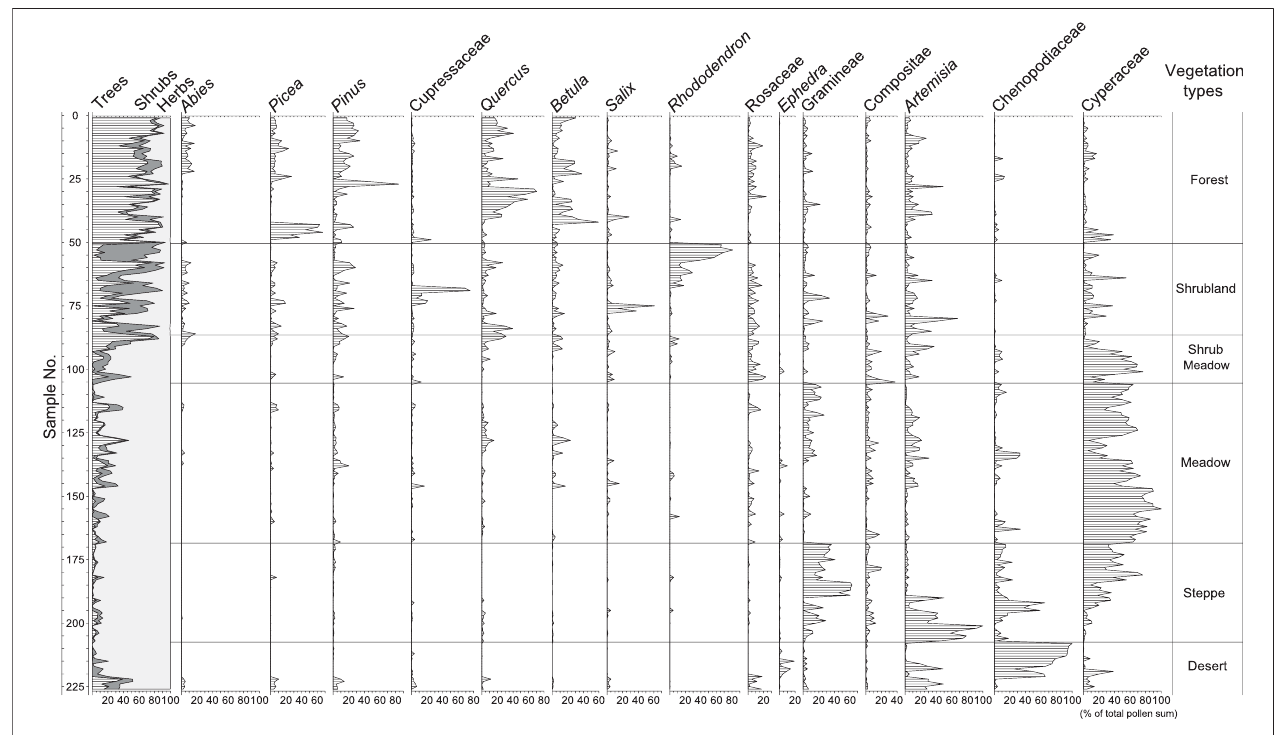
FIGURE 9 | Summary pollen diagram of selected pollen types for surface samples in the TP.